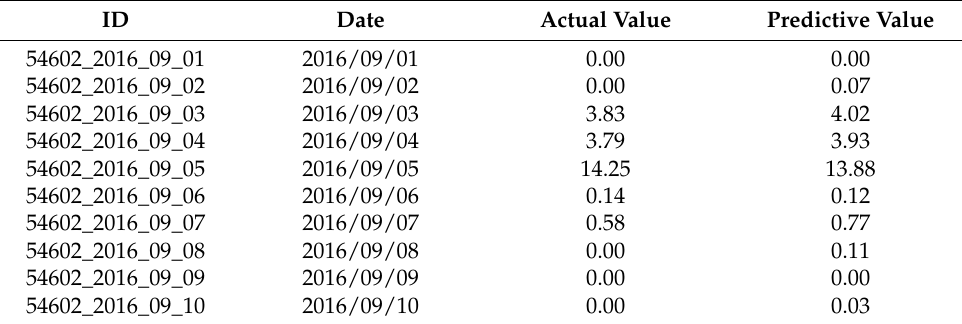
Table 6. Part of the output of TabNet-PF is based on rainy-season